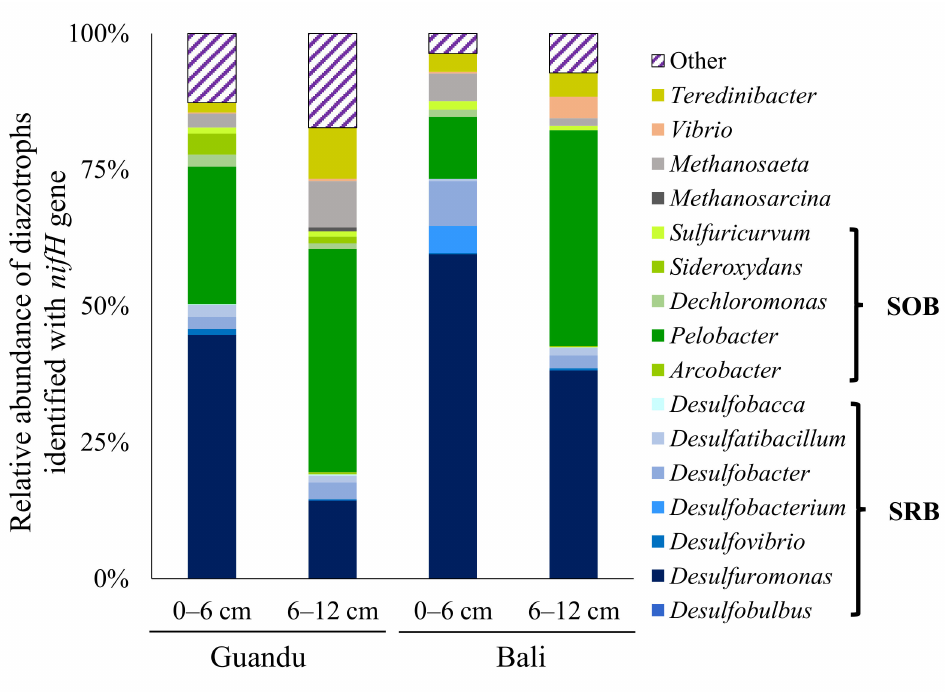
Figure 7. The relative abundances of diazotrophic genera identified with the nifH gene in Guandu and Bali mangrove forest soils. Sulfate-reducing bacteria (SRB) are in blue, sulfur and sulfide-oxidizing bacteria (SOB) are in green, and methane related archaea are in grey.